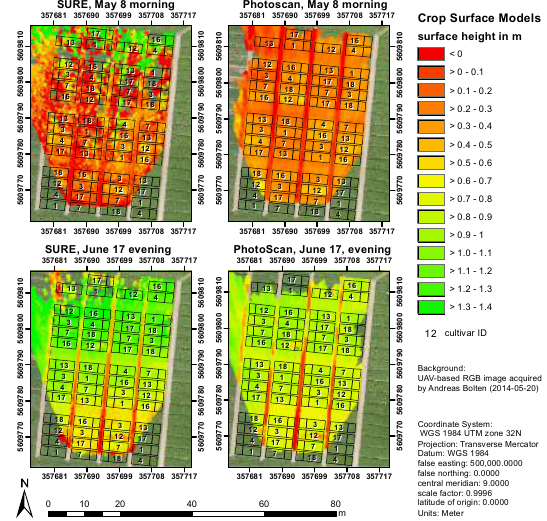
Figure 4. SURE and PhotoScan CSMs for two acquisition dates to the cameras. Figure 3 shows one such point cloud from two points of view, illustrating the noise. In Figure 4, the CSMs for the evening acquisition time of May 8 and June 17 generated by both SURE and PhotoScan are shown. The May 8 CSM clearly shows the effect the noise in the point cloud has on the generated CSM. In contrast, the June 17 CSMs show that SURE is also capable of satisfactory results with regard to noise and point density in the point cloud. The combination of VisualSfM and CMVS/PMVS2 did not gen- erate satisfactory results, regardless of how the georeferencing of the point clouds was performed. A visual inspection of the gener- ated dense point clouds shows the plot geometry is not correctly derived: The parallel plot borders facing away from the cameras are not parallel in the generated point clouds but diverge the fur- ther from the camera position they are, see Figure 5 in combina- tion with Figure 1. The footpaths between the plots are clearly visible, and when comparing with Figure 1, it is obvious that the geometry is not correctly derived. Regarding point density and noise, however, the results look promising: The point